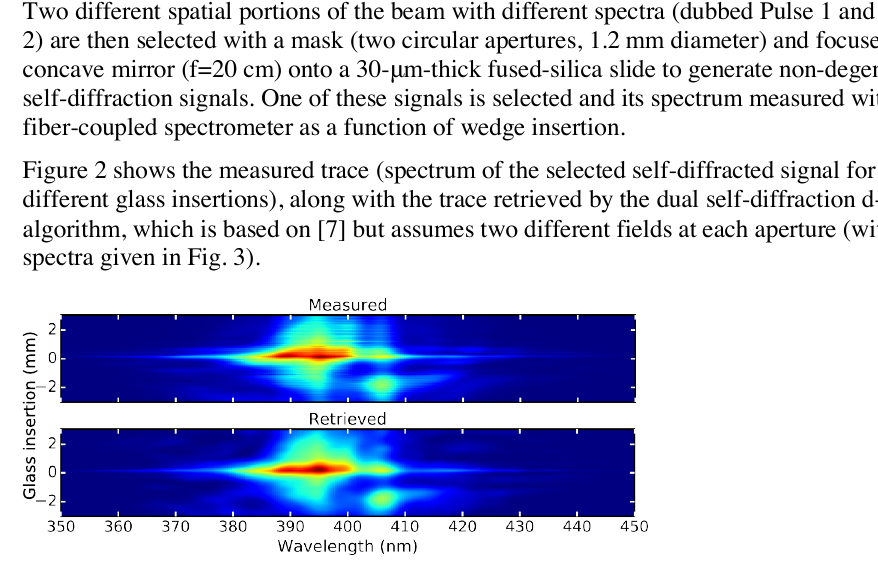
Fig. 2. Measured (top) d-scan trace and retrieved (bottom) d-scan trace assuming non-degenerate self-